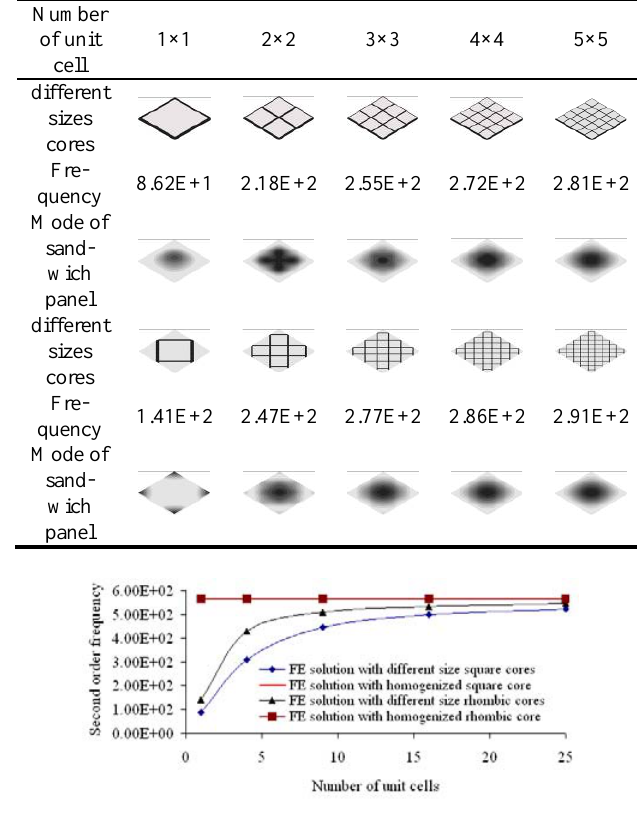
ncy er vi Fig.22. Freque variation of the second ord bration differe ize square and rh bic cores with nt s om